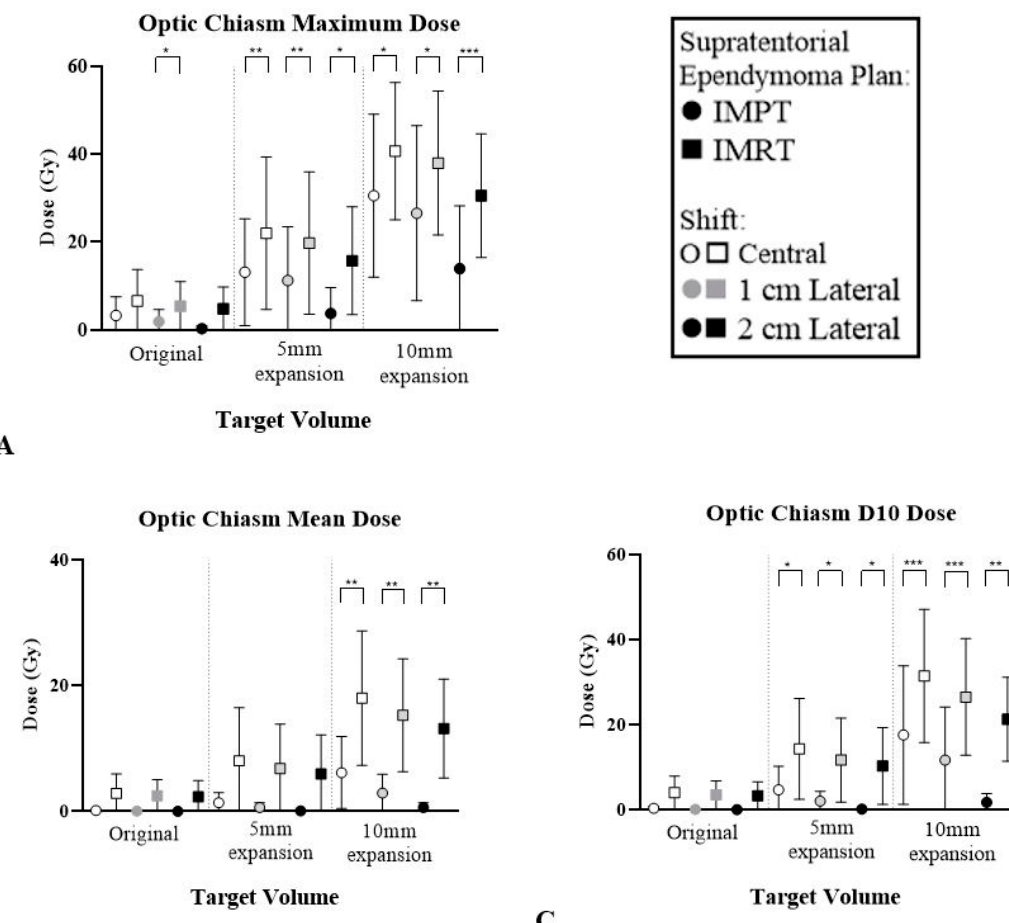
Figure 7. Average dose optic chiasm across six patients across IMPT and IMRT plans for three STEP volumes and locations. ( A ) Maximum dose. ( B ) Mean dose. ( C ) Dose to 10% of the structure. Paired T-test error bars represent the 95% confidence interval of the mean. * p < 0.05, ** p < 0.01, *** p < 0.001.